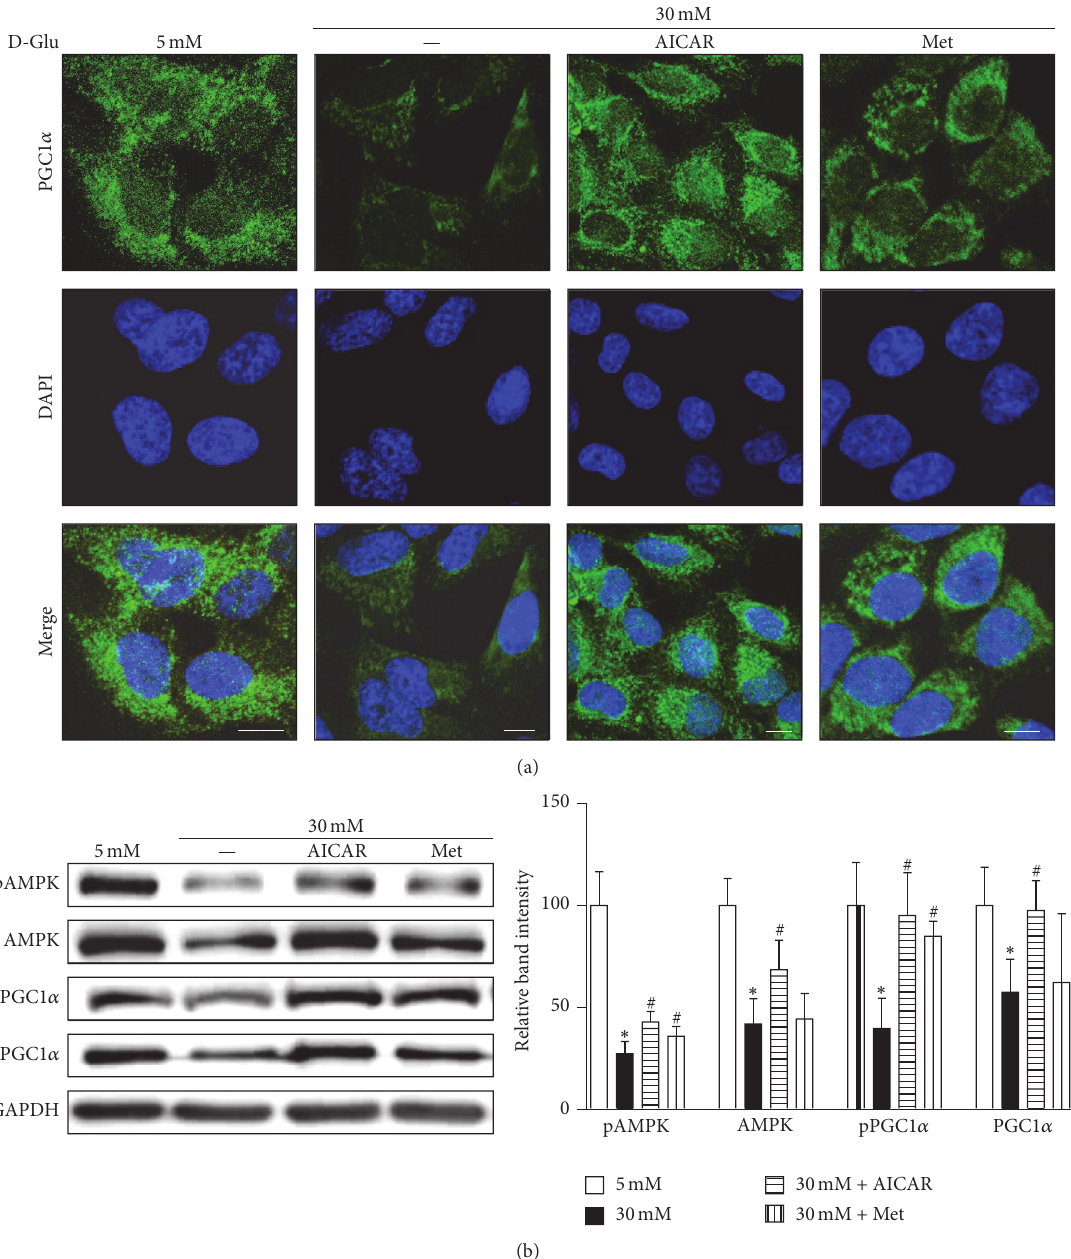
Figure 3: AICAR and metformin protect against the decrease in AMPK and PGC1 𝛼 expression under high-glucose (HG, 30 mM) concentrations in human renal proximal tubular cells. (a) Representative confocal fluorescence images of PGC1 𝛼 indicate that AICAR or metformin restore PGC 𝛼 activity in human RPTCs subjected to HG concentrations. (b) Immunoblotting results show that increased AMPK activity and restored PGC1 𝛼 expression are observed in human RPTCs subjected to high glucose and AICAR or metformin treatment ( ∗ 𝑝 < 0.05 versus 5mM glucose treatment; # 𝑝 < 0.05 versus 30mM glucose treatment; scale bar 10 𝜇